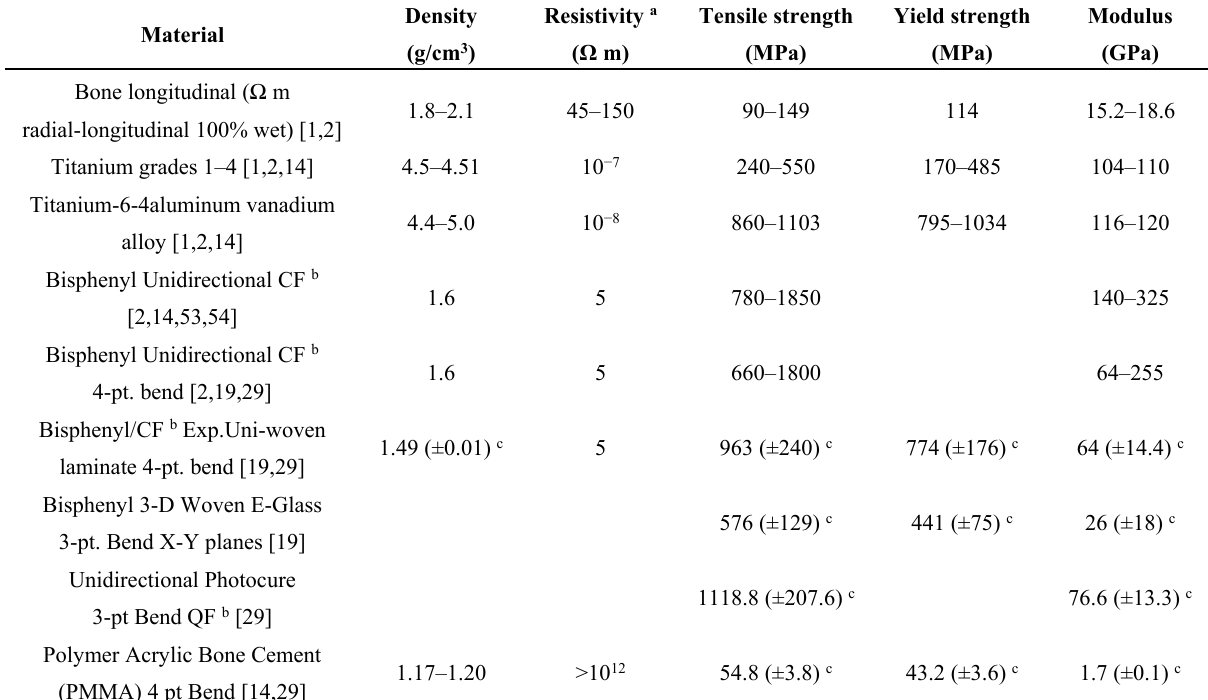
Table 1. Biomaterial